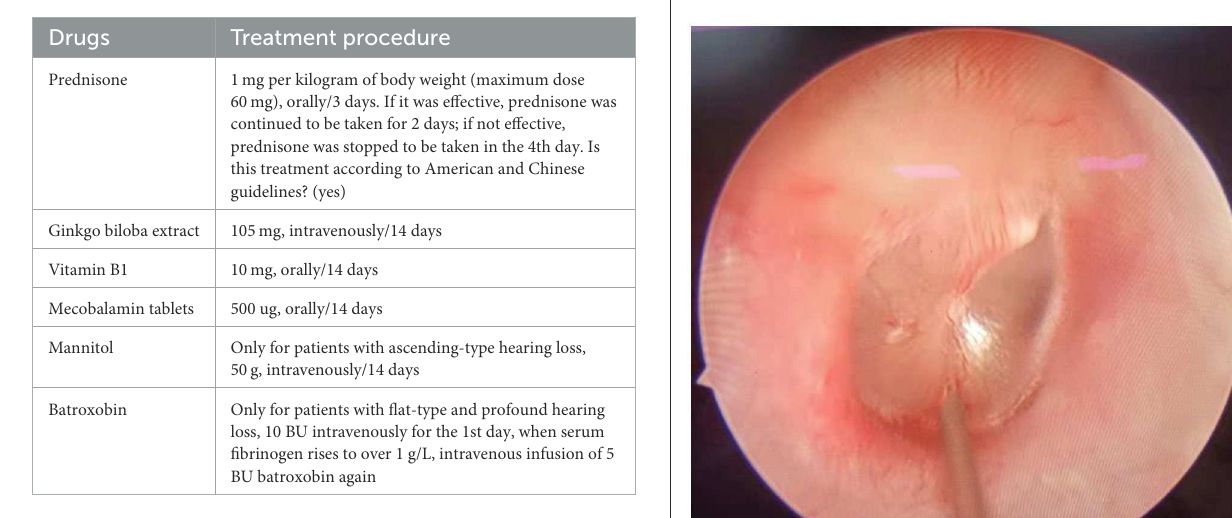
TABLE 1 Protocol of SSNHL treatment.